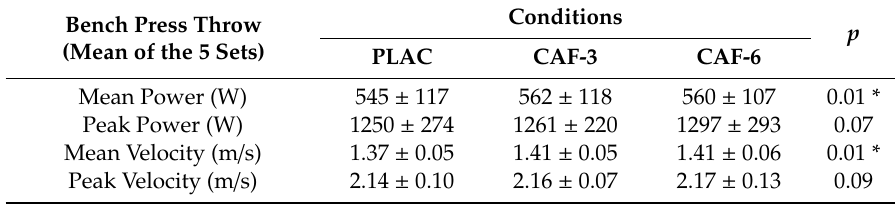
Table 1. The main e ff ect for substance on performance variables measured during 5 sets of the bench press throw with the ingestion of 3 and 6 mg / kg / b.m. of ca ff eine or a placebo.